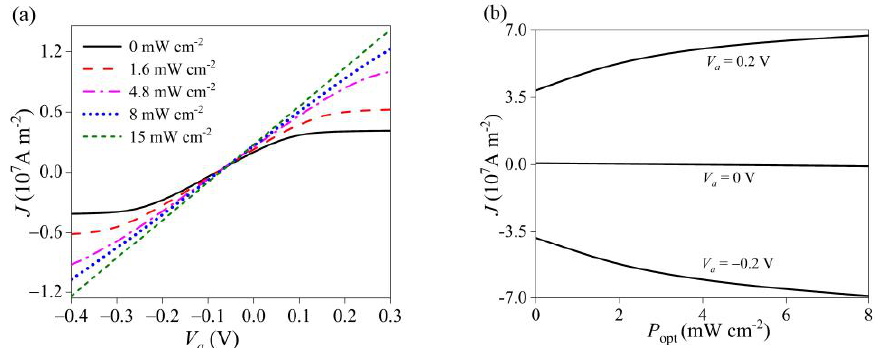
Figure 5. The characteristics of ( a ) I – V and ( b ) I – P opt in a GaN nanowire under different ultraviolet